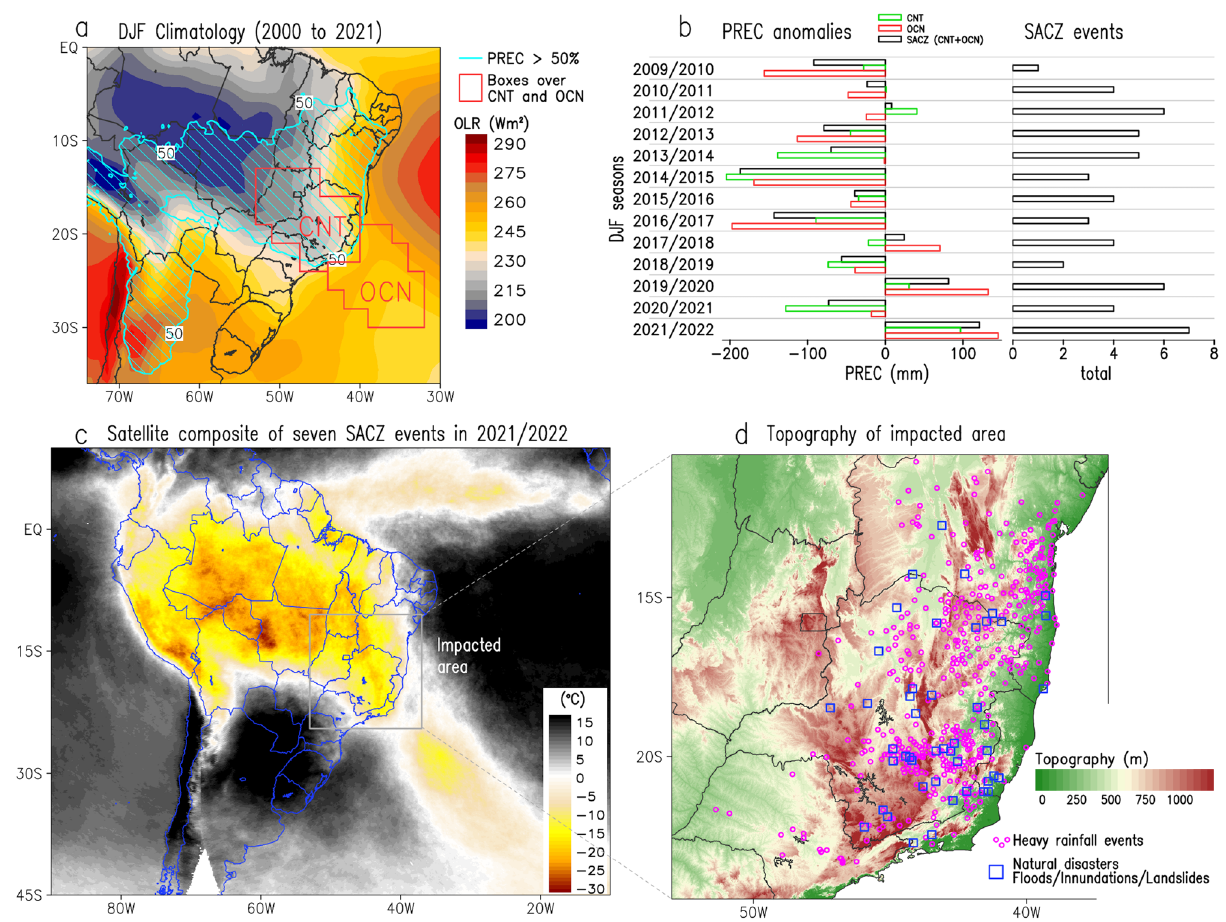
Figure 1. ( a ) December, January, and February (DJF) climatology for the period from 2000 to 2021 of Outgoing Longwave Radiation (OLR) shaded (W m −2 ) and percentage of precipitation (PREC) blue hatched (contours, %) emphasizing areas containing more than 50% of the annual total. ( b ) Time-series of box-averaged OLR, PREC anomalies over the continent (CNT), the ocean (OCN), and the whole SACZ area (CNT + OCN), and the total number of SACZ events (according to Rosa et al. 8 ) during each DJF season. ( c ) Cloud top brightness temperature (°C) composite for the seven oceanic SACZ events in DJF 2021/2022. ( d ) Topography (shaded in m). The CNT and OCN areas are indicated in ( a ) as polygons in red lines. Symbols in ( d ) display heavy